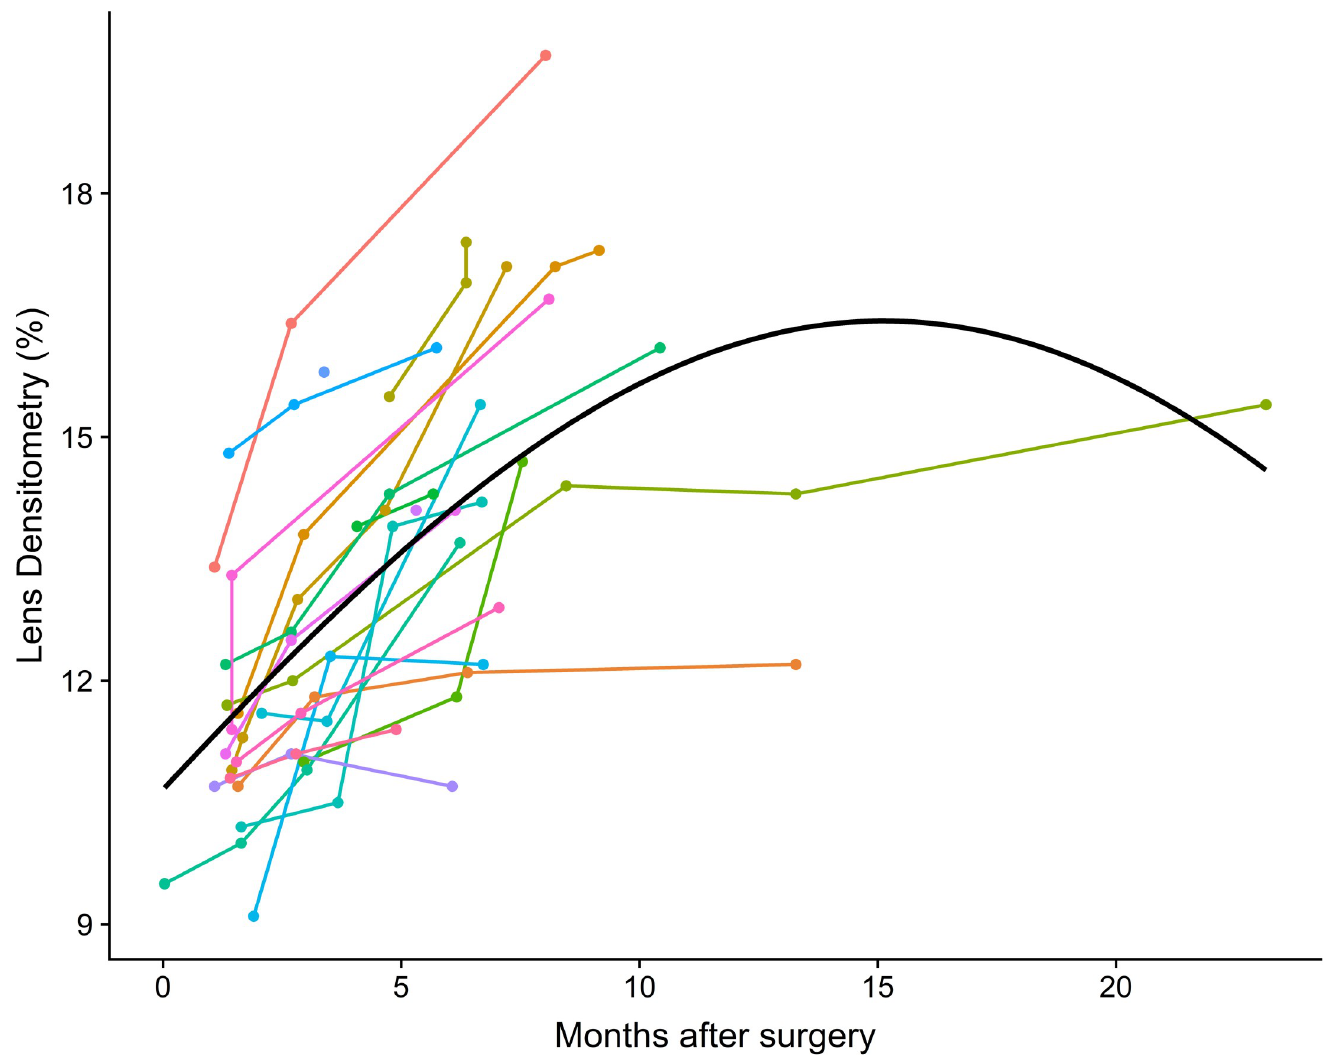
Fig 2. Trajectories of lens densitometry changes. Trajectories of lens densitometry changes (observed post-surgical measurements) for treated eyes.